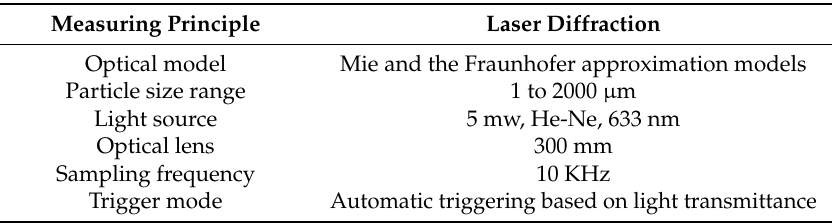
Table 1. Specifications of the laser particle size